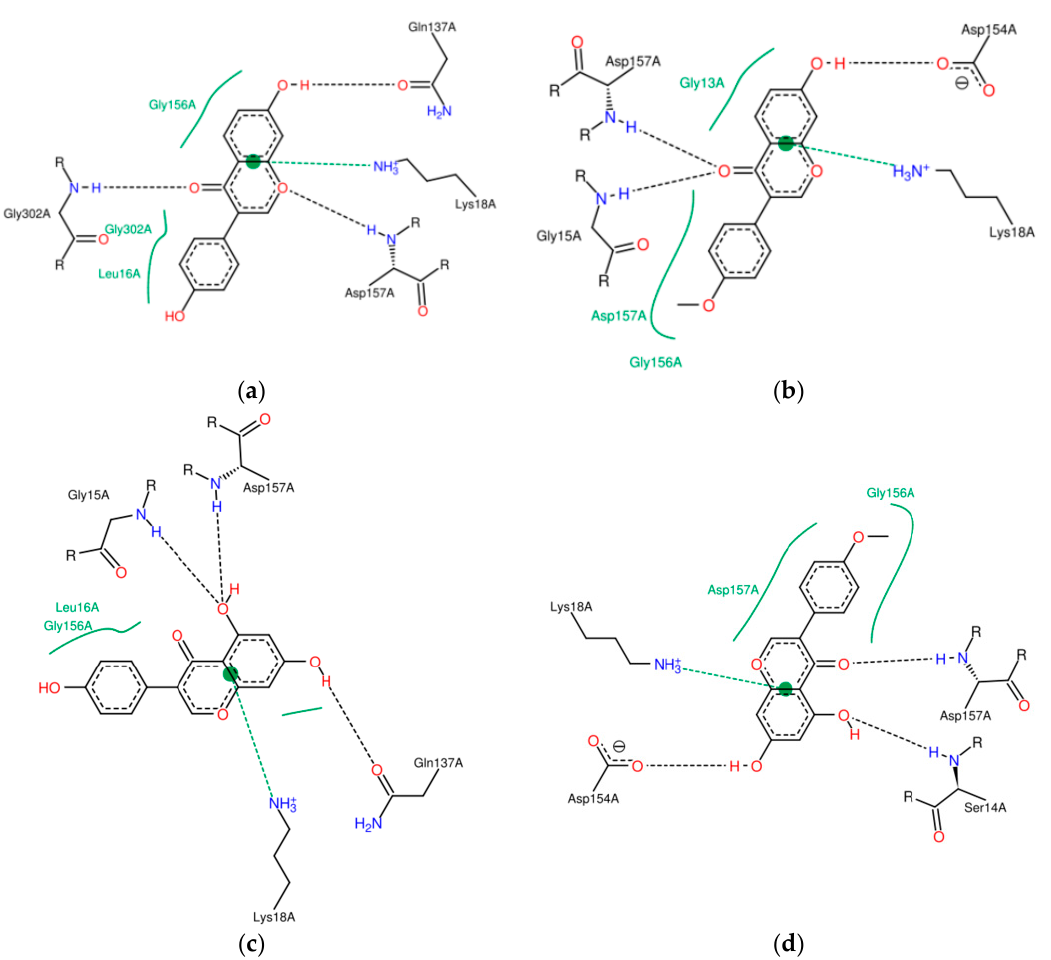
Figure 1. Depiction (in 2D) of the main interactions established between the active site of actin and ( a ) genistein; ( b ) formononetin; ( c ) daidzein; ( d ) biochanin A. Continuous lines represent hydrophobic interactions, while dashed lines show hydrogen bonds and dashed lines connected to the bond between ring A and C represent π - π interactions.